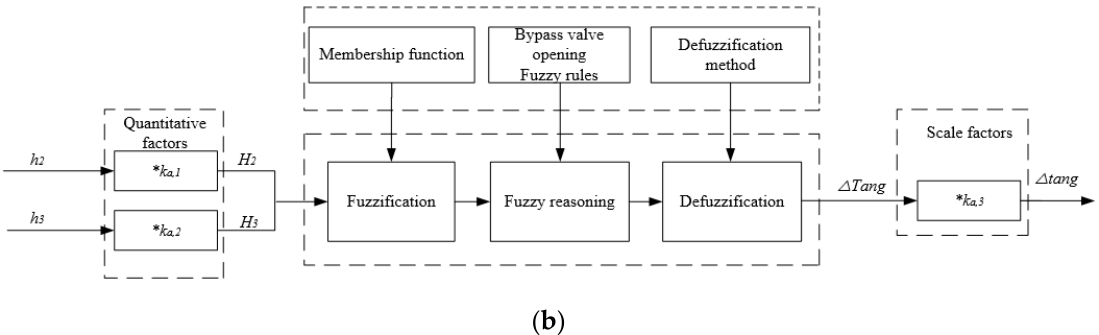
Figure 6. Two-input two-output FLA. ( a ) Fuel FLA; ( b ) air FLA.